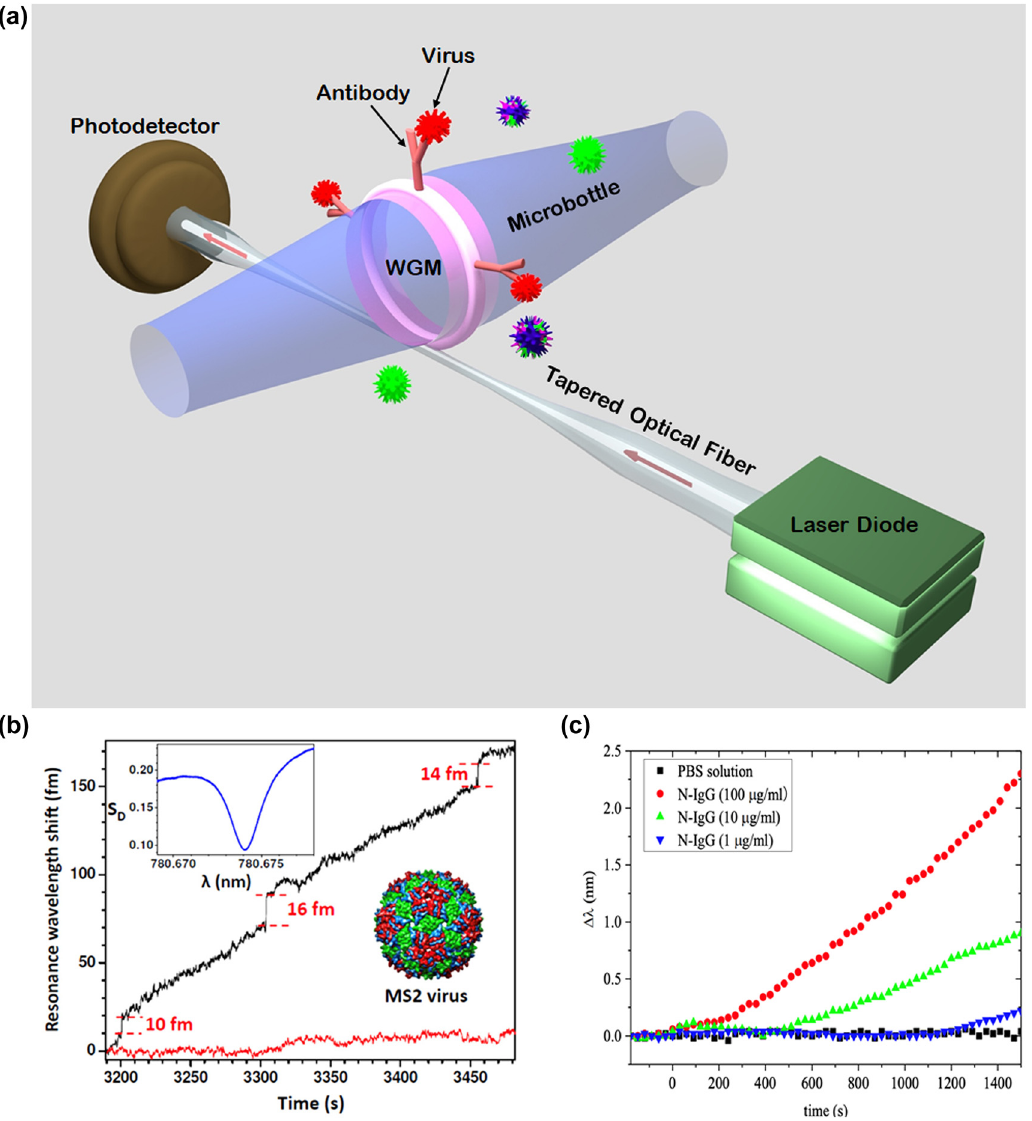
Figure 6: Illustration of the Whispering Gallery Mode (WGM) technique for virus detection. (a) Concept of detecting single virus in a microresonator-based whispering gallery mode (WGM) biosensor. (b) Resonance shift of a WGM resonator of radius 45 μ m with gold nanoshell at its equator due to MS2 virus adsorption (upper trace) and background in the absence of nanoshell or MS2 virus (lower trace). Adapted with permission from ref. [77]. Copyright [2012] AIP Publishing. (c) Resonance shift of a WGM microsphere for detection of COVID-19 virus infection through capture of IgG antibodies with different concentrations. Adapted with permission from ref. [78]. Copyright [2020] John Wiley and